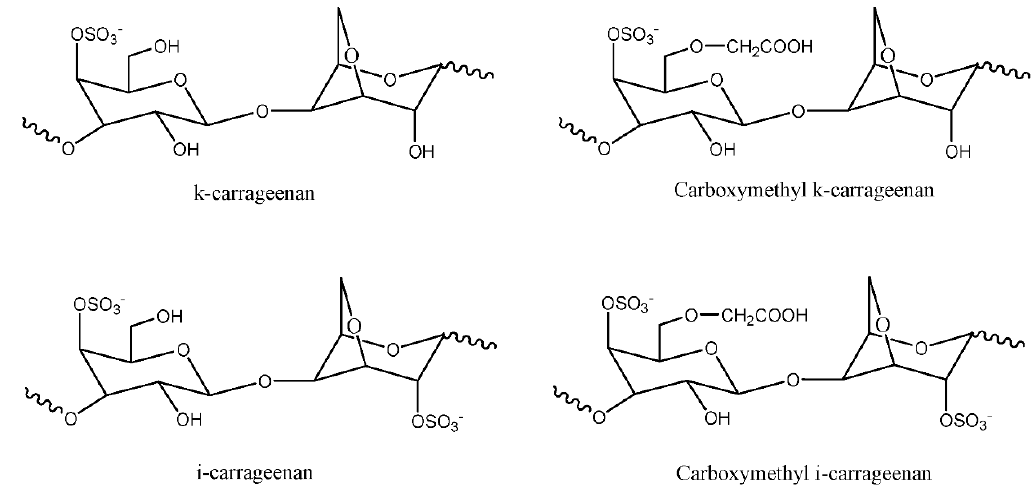
Figure 8. Representative units of κ -carrageenan, i-carrageenan, CMC κ -carrageenan, and CMC